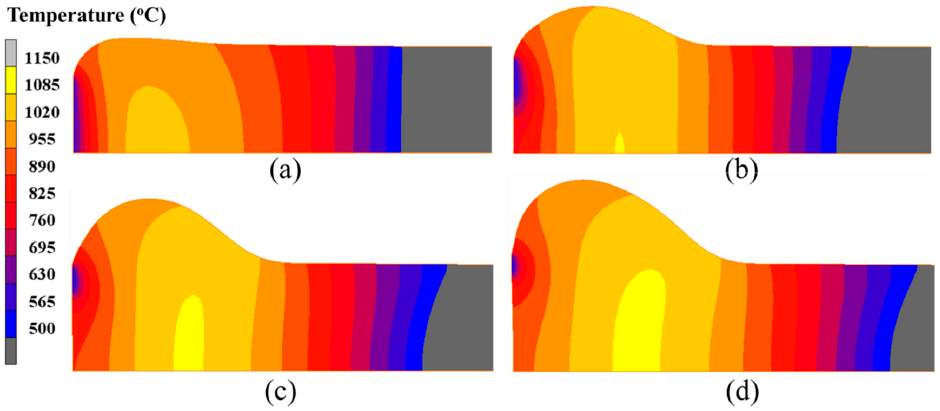
Figure 11. Temperature field distributions in the billet at different moments of the electric upsetting process: ( a ) 200 s, ( b ) 250 s, ( c ) 300 s and ( d ) 350 s.